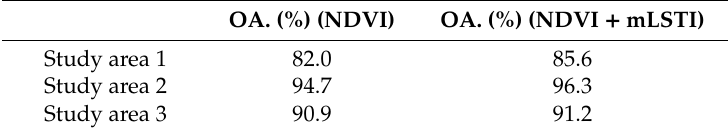
Table 4. Classification accuracy based on the NDVI + mLSTI long time